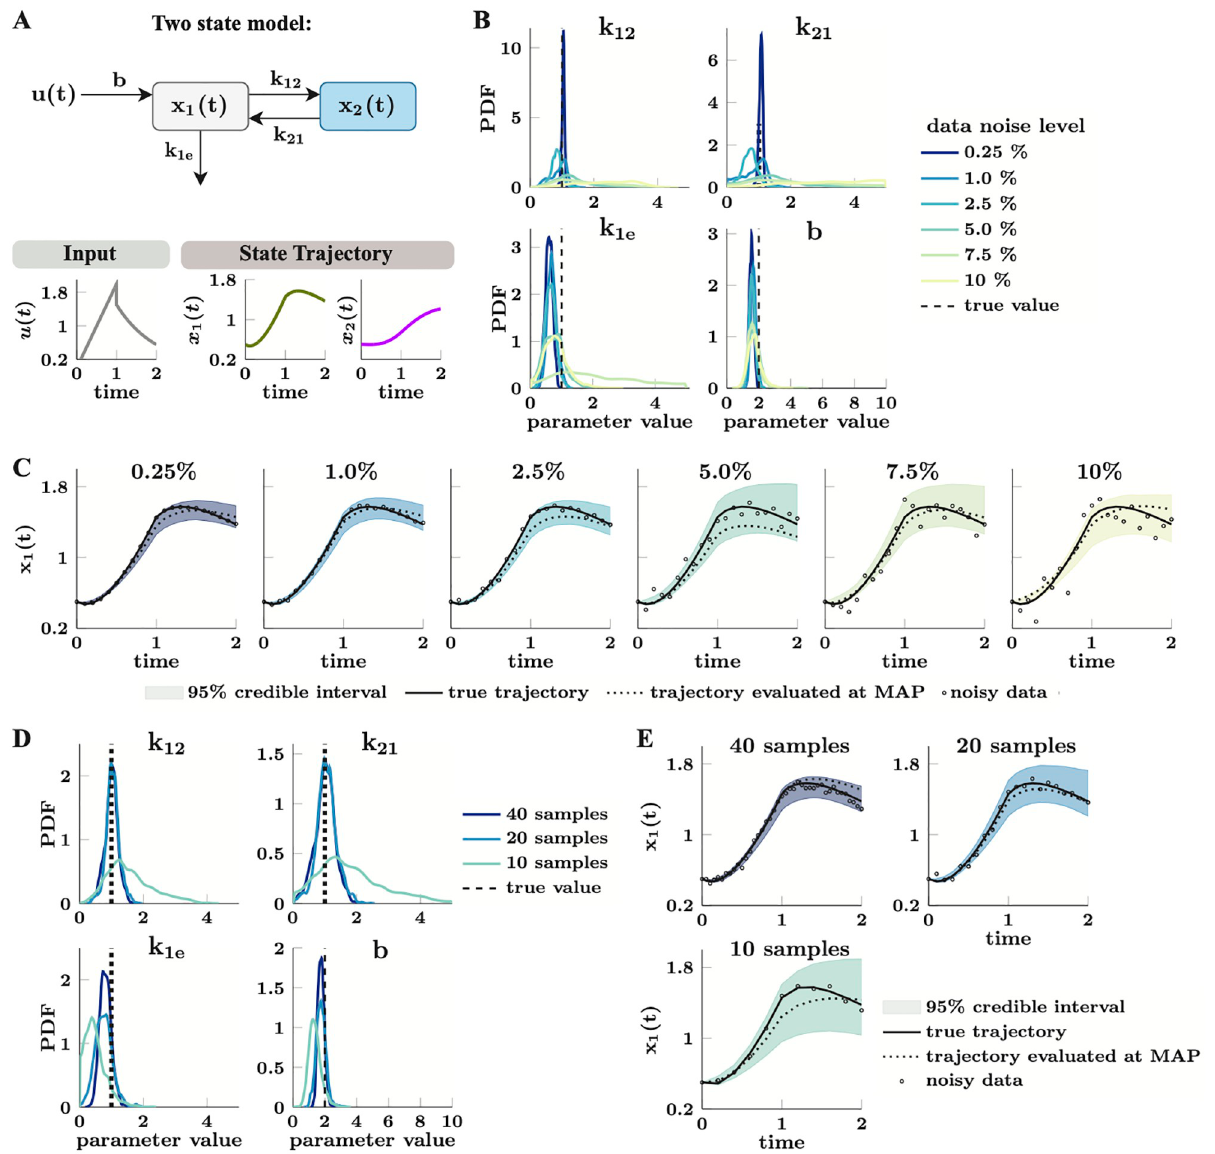
Fig 3. Parameter estimation for a simple two-state model. ( A ) Top row: Network diagram of the two-state model with states, x 1 ( t ), x 2 ( t ), input function u ( t ), and four unknown parameters, θ ¼ ½ k ; k ; k ; b � > . Bottom row: Trajectories of the input function u ( t ) and corresponding state 1 e 12 21 f trajectories. The input has at least one non-zero derivative to ensure that all model parameters are globally structurally identifiable following [55]. ( B ) Marginal posterior distributions of the model parameters show increasing uncertainty in the parameter estimates (e.g. widening and flattening) with increasing levels of additive normally distributed measurement noise with mean zero. We control the noise level by setting the noise covariances to the specified percentage of the standard deviation of each state variable. The dashed black vertical lines indicate each parameter’s nominal (true) value. Marginal posteriors are visualized by fitting a kernel density estimator to 20,000 MCMC samples obtained using CIUKF-MCMC with the delayed rejection adaptive Metropolis (DRAM) MCMC algorithm after discarding the first 10,000 samples as burn-in. ( C ) Posterior distributions of the trajectory of x 1 ( t ) reflect increasing parameter estimation uncertainty in panel B. The true trajectory (solid black line) shows the dynamics with the nominal parameters, dashed black lines show that trajectory with the most probable set of parameters (MAP point), and the empty circles show the noisy data at the specified noise level. The 95% credible interval shows the region between the 2.5th and 97.5th percentiles that contains 95% of the 5, 000 trajectories. ( D ) Marginal posterior distributions of the model parameters show increasing uncertainty (widening and flattening) with increasing data sparsity (fewer samples). We simulate data sparsity by sampling the simulation from 0 � t � 2 with three time steps, Δ t = 0.05 (40 experimental samples), Δ t = 0.1 (20 experimental samples) and Δ t = 0.2 (10 experimental samples). Marginal posteriors are fit to 20,000 MCMC samples obtained as in panel B. ( E ) Posterior distributions of the trajectory of x 1 ( t ) reflect increasing parameter estimation uncertainty seen in panel